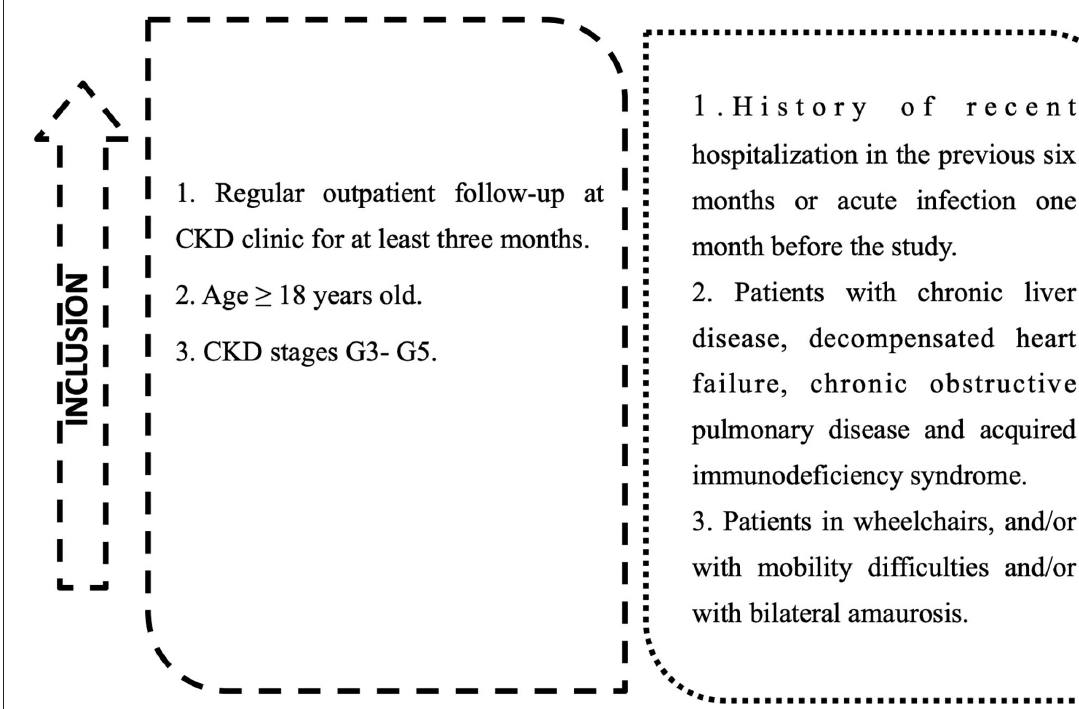
FIGURE 1 | Inclusions and exclusions criteria for study